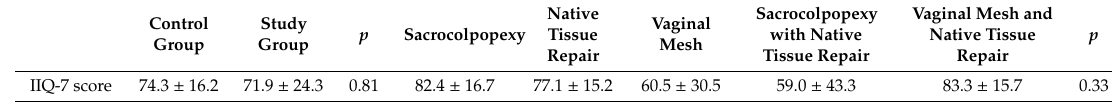
Table 4. The results of the IIQ-7 questionnaire in both groups before sling